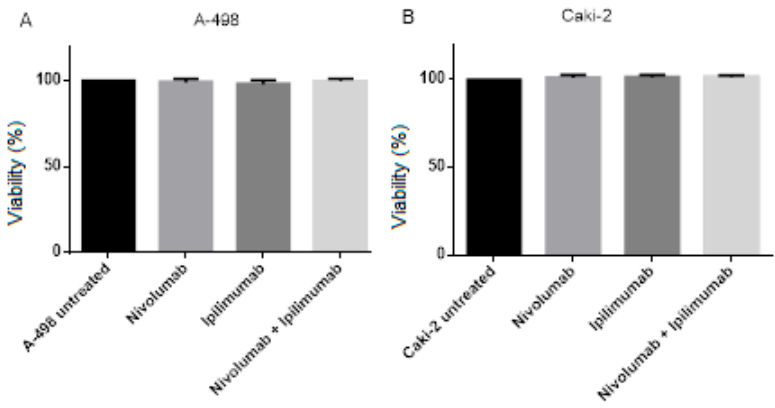
Figure 4. Effects of nivolumab and ipilimumab on the number of viable cells after 72 h on A-498 or Caki-2 cells. ( A ) The different viability of A-498 comparing to A-498 untreated control. p value = 0.3598 ( B ) The different viability of Caki-2 comparing to Caki-2 untreated control. p value = 0.2658.